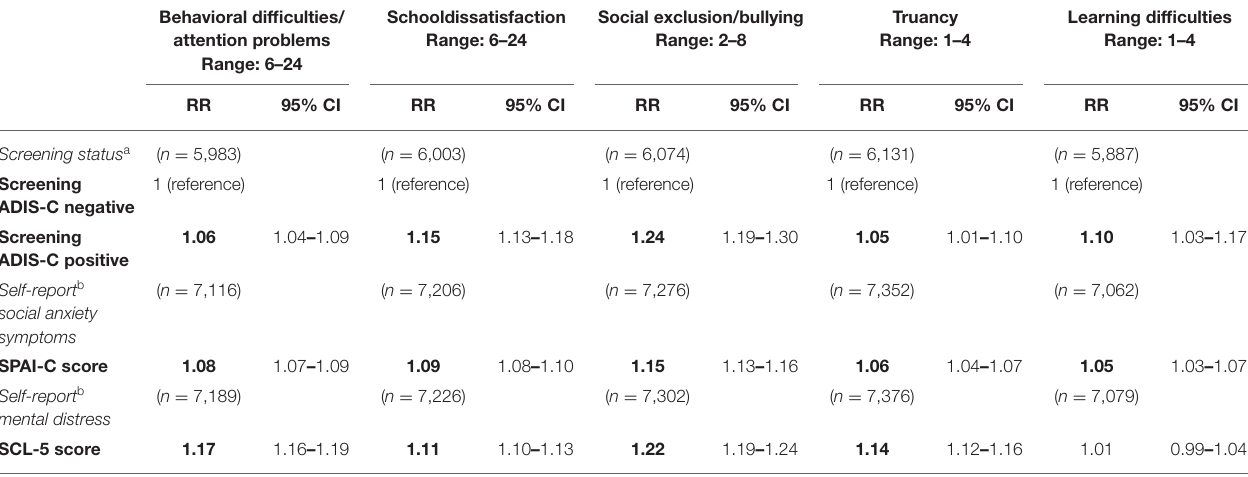
TABLE 2 | Associations * between symptoms of SAD and mental distress and indicators of school functioning among adolescents.